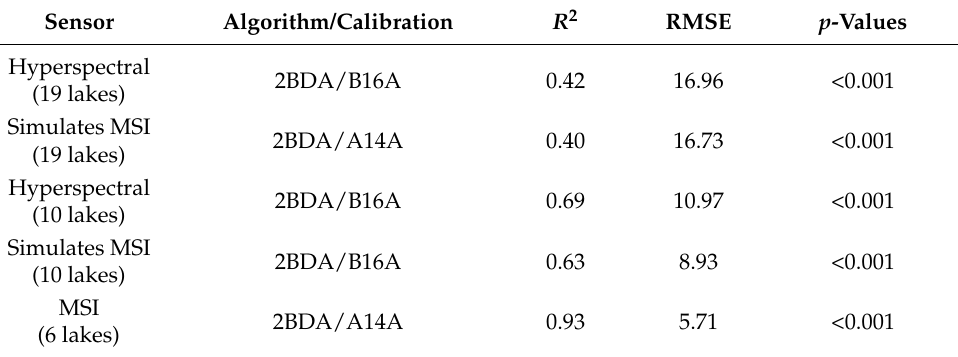
Table 6. Summary of the metrics of the best algorithm per sensor and data set used in this study.